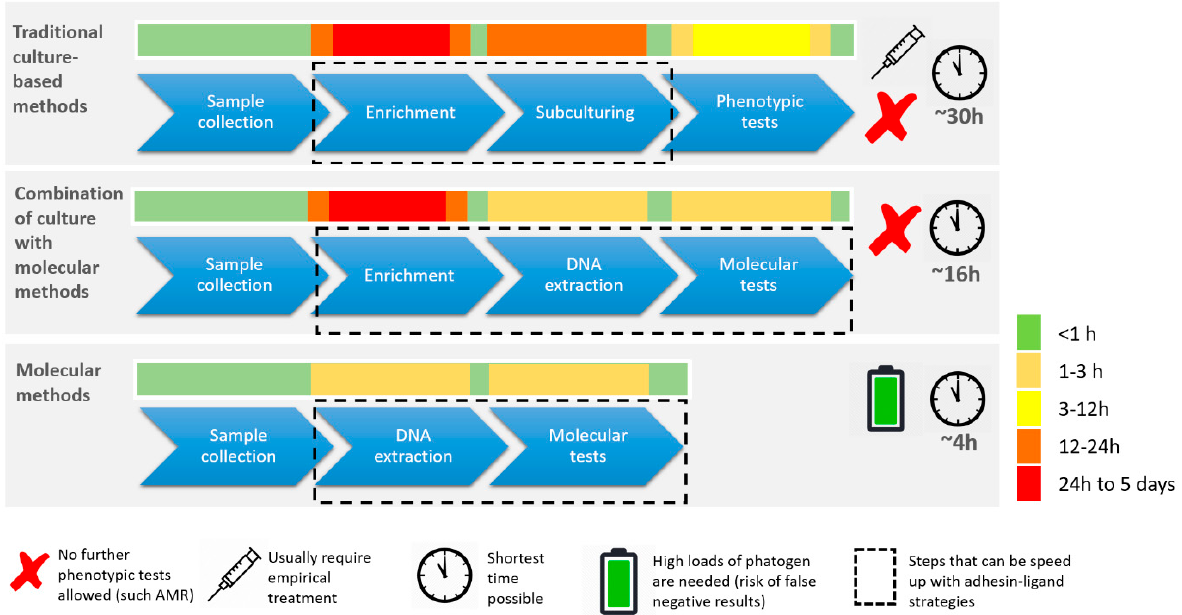
Figure 2. Comparison of culture-based versus molecular diagnostics in routine clinical microbiology. Innovative clinical diagnostics with inclusion of molecular methodology requires careful consideration of many important test parameters among which sensitivity, specificity, cost, shelf life, robustness, simplicity, and user-friendliness. Although molecular techniques are faster, there is frequently a mandatory need for cultivation throughout the diagnostic process. Viable cells are often required for storage, downstream AST or simply for reproducibility testing at a later stage.